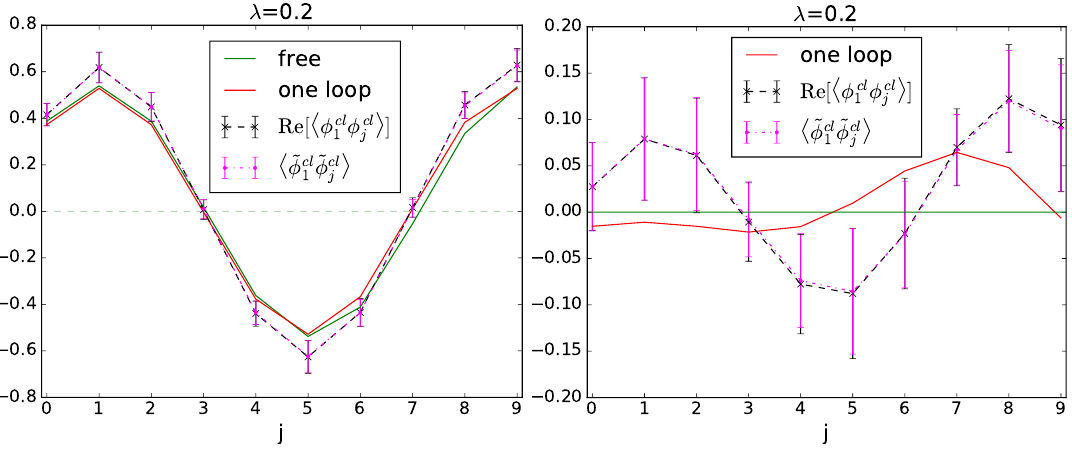
Figure 6 . The full classical-statistical and quantum correlators (cl-cl) for a free and interacting theory at (cid:21) = 0 : 2. The (cid:12)gure on the right shows the result of subtracting the free propagator. The red line is the perturbative 1-loop result.